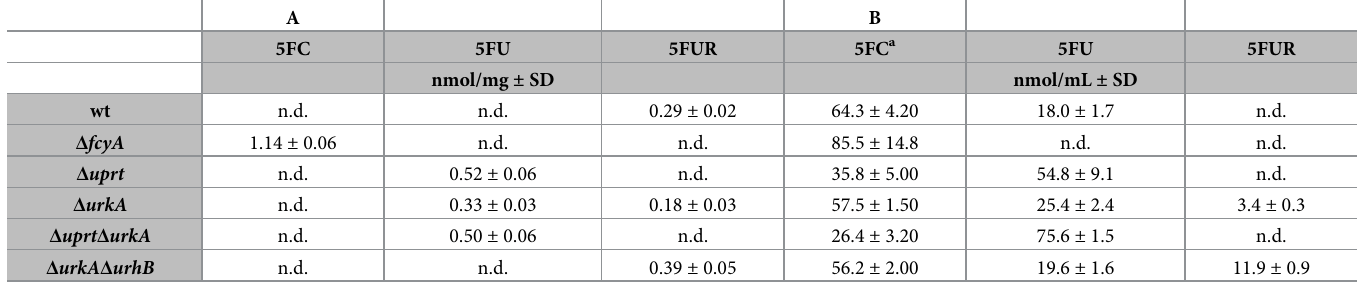
Table 1. Determination of fluoropyrimidine levels in 5FC treated strains. HPLC-based analysis of (A) intra- and (B) extracellular 5FC, 5FU and 5FUR levels of 5FC treated wt and pyrimidine salvage pathway mutants with highest degrees of resistance to 5FC, 5FU and/or 5FUR; n.d. not